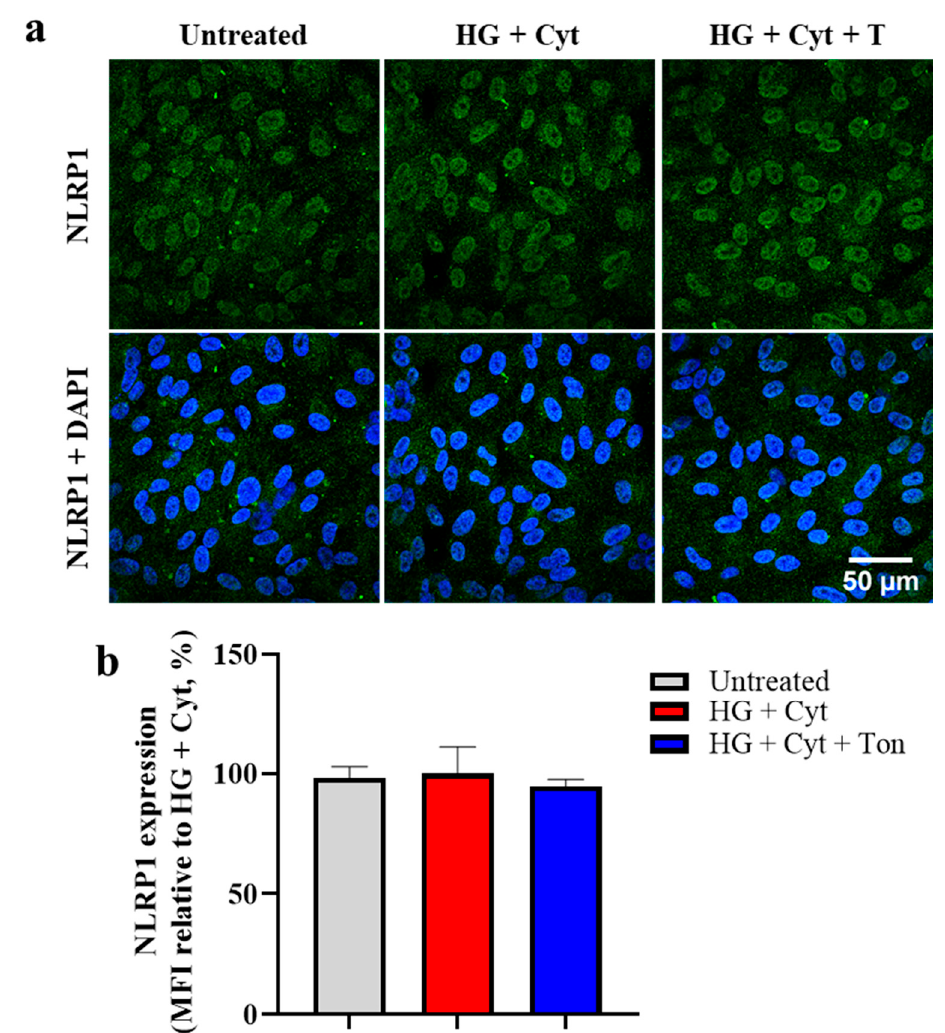
Figure 4. Effect of HG + Cyt and connexin43 hemichannel block with tonabersat on NLRP1 labeling intensity or distribution. Panel ( a ) shows NLRP1 localization remained consistently nuclear across all treatment groups. No changes in NLRP1 protein localization ( a ) or total labeling levels (mean fluorescence intensity) ( b ) were observed following HG + Cyt challenge or the addition of tonabersat, indicating that NLRP1 is not activated in this model. Data are presented as mean + SEM. Statistical analysis was carried out using one-way ANOVA. n = 5; scale bar = 50 µm.